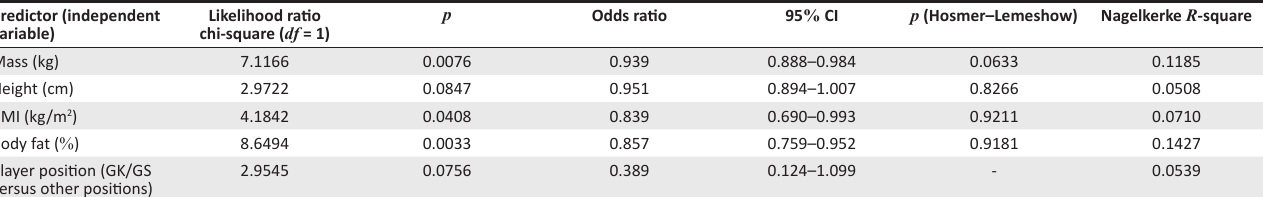
TABLE 3: Morphological variables and player position as potential predictors of injury (univariate logistic regression). Predictor (independent